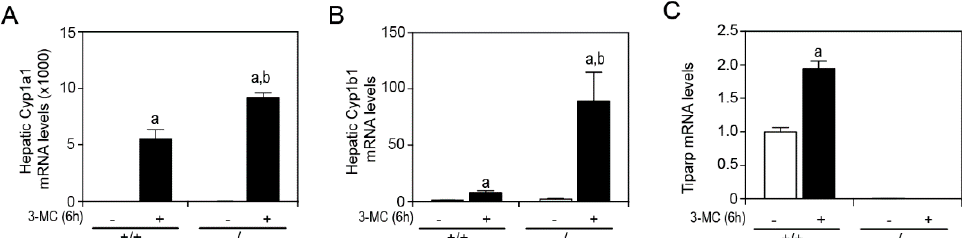
Figure 1. Hepatic gene expression of aryl hydrocarbon receptor (AHR) target genes in male mice 6 h after treatment with 100 mg/kg 3MC. Hepatic RNA was isolated, reverse transcribed and mRNA expression levels of ( A ) Cyp1a1, ( B ) Cyp1b1 and ( C ) Tiparp were determined by qPCR. Data represent the mean ± SEM; n = 3 for all genes. a p < 0.05 two-way ANOVA comparison between genotype-matched corn oil- and 3MC-treated mice and b p < 0.05 two-way ANOVA comparison between treatment-matched WT and Tiparp − / − mice followed by a Tukey’s post hoc test.